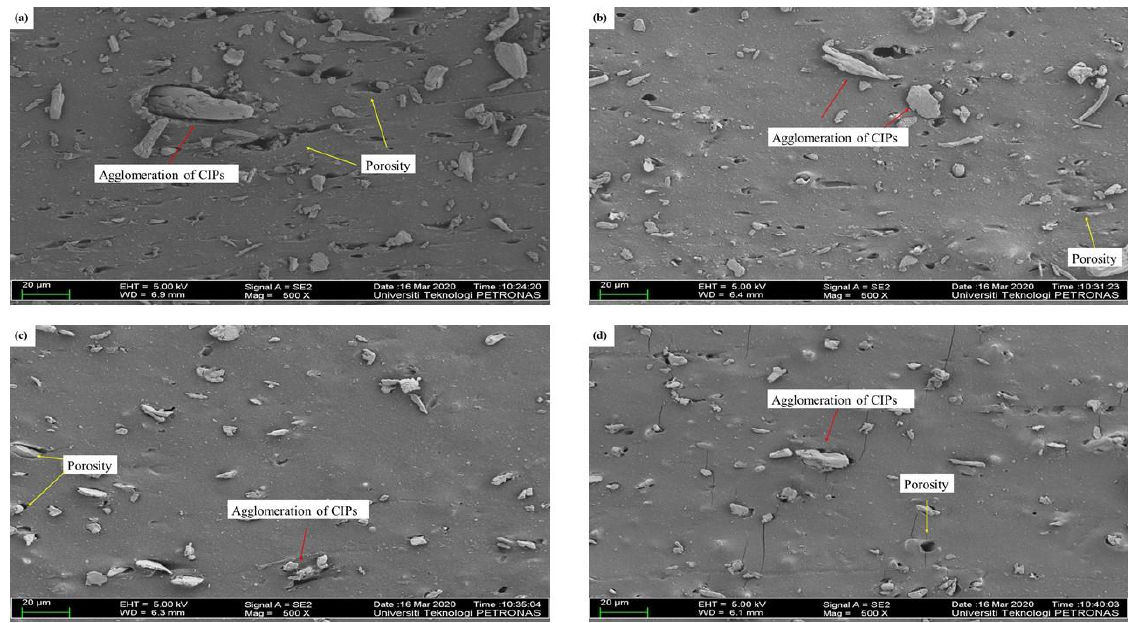
Figure 5. Microstructures of MREs for different ratios of LMO:AO. ( a ) LMO 1, ( b ) LMO 2, ( c ) LMO 3, and ( d ) LMO 4.